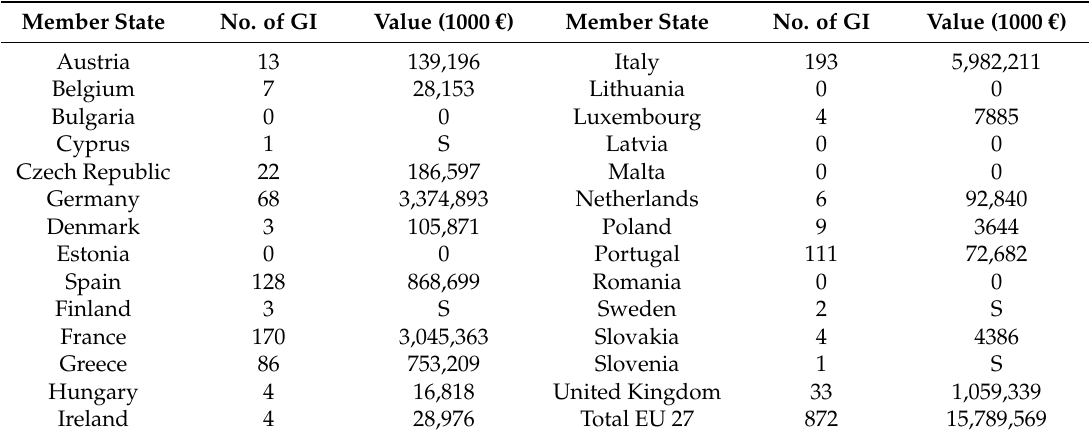
Table 1. Geographical Indications (Protected Designation of Origins (PDO) and Protected Geographical Indications (PGI)) by European Member State,